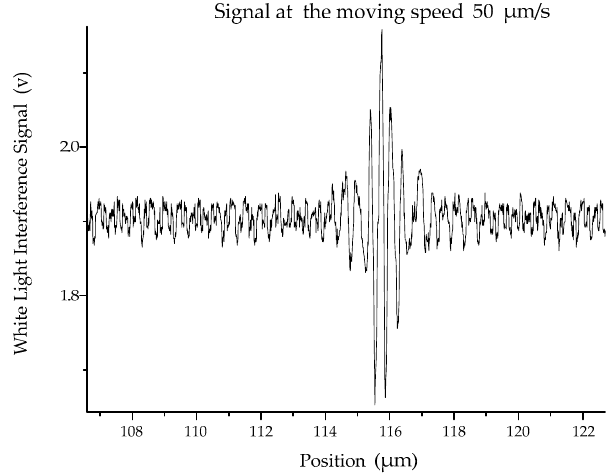
Figure 8. Positioning signal at moving speed of 50 µm/s.